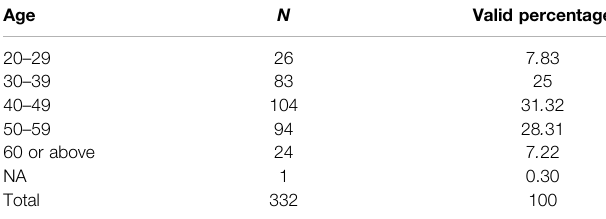
TABLE 2 | Age ranges of the